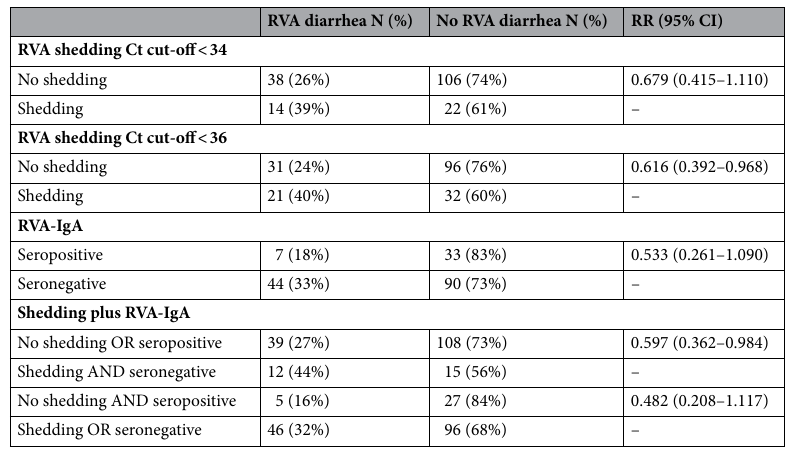
Table 1. RVA diarrhea between 18 and 104 weeks in vaccinated infants following Rotarix dose 2. Seropositive: RVA-IgA ≥ 20 U/mL; seronegative: RVA-IgA < 20 U/mL. CI confidence interval, Ct cycle threshold, RR relative risk, RVA group A